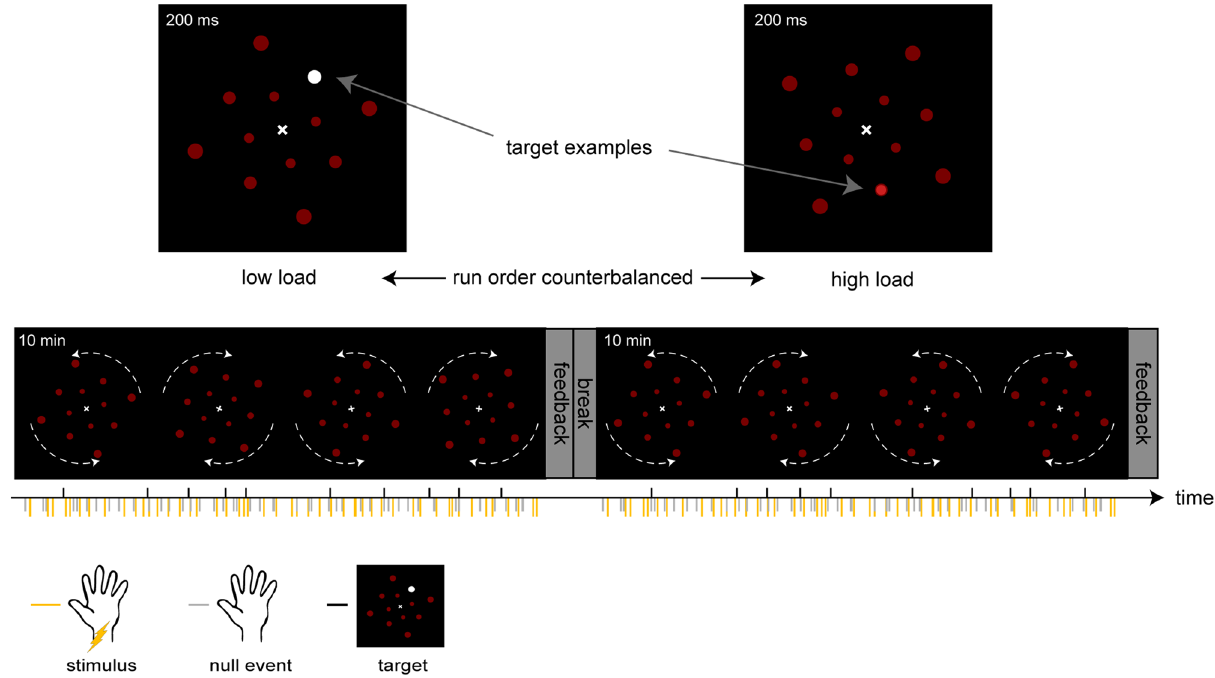
Figure 1. Schematic diagram of the experimental procedure. There was one low-load and one high-load run with 50 somatosensory stimulus events and 50 null events each. The high- and low-load conditions differed in the difficulty of the tasks: The target detection with subtle color change corresponded to the high-load task, and the detection with clearly visible color change corresponded to the low-load task. There were 10 target presentations per run. The order of the runs was counterbalanced between subjects. Rotation changes are indicated with dashed white arrows for illustration purposes. Their actual occurrence was more frequent and variable in timing (see main text for details). The timeline illustrates the time points of stimulus events (orange dashes), null events (grey dashes), and visual target stimuli (black